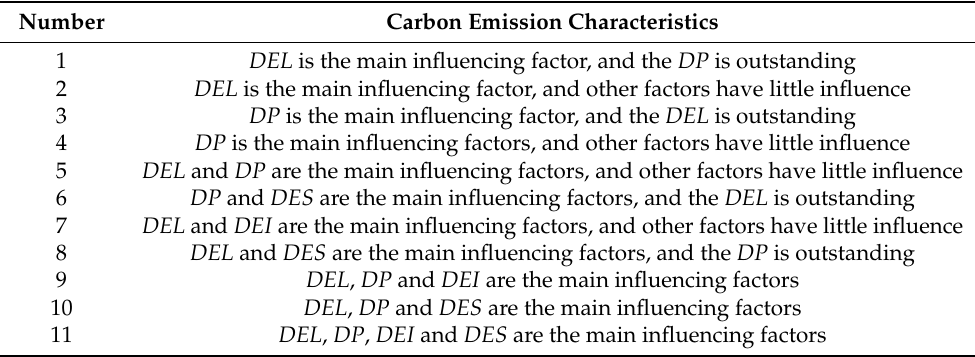
Table 4. Classification of carbon emission